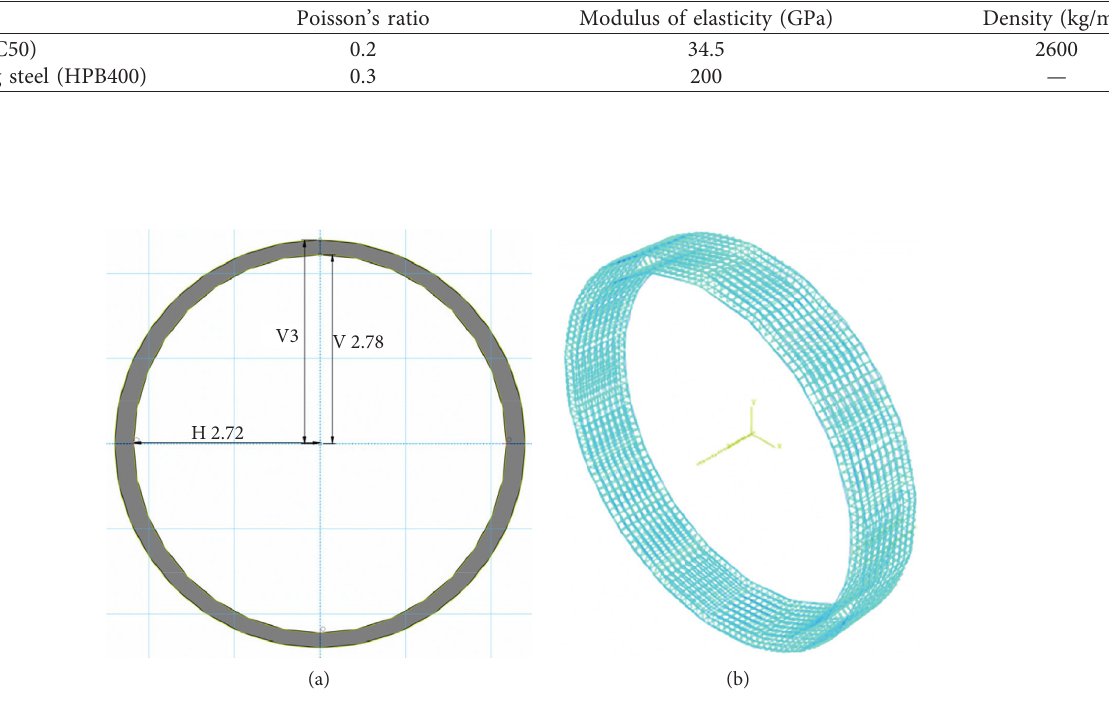
Figure 7: Finite element model of shield tunnel linings and reinforcement. (a) Sketch of cross section of outer circular and inner elliptical shield tunnel linings. (b) Shield tunnel lining reinforcement.